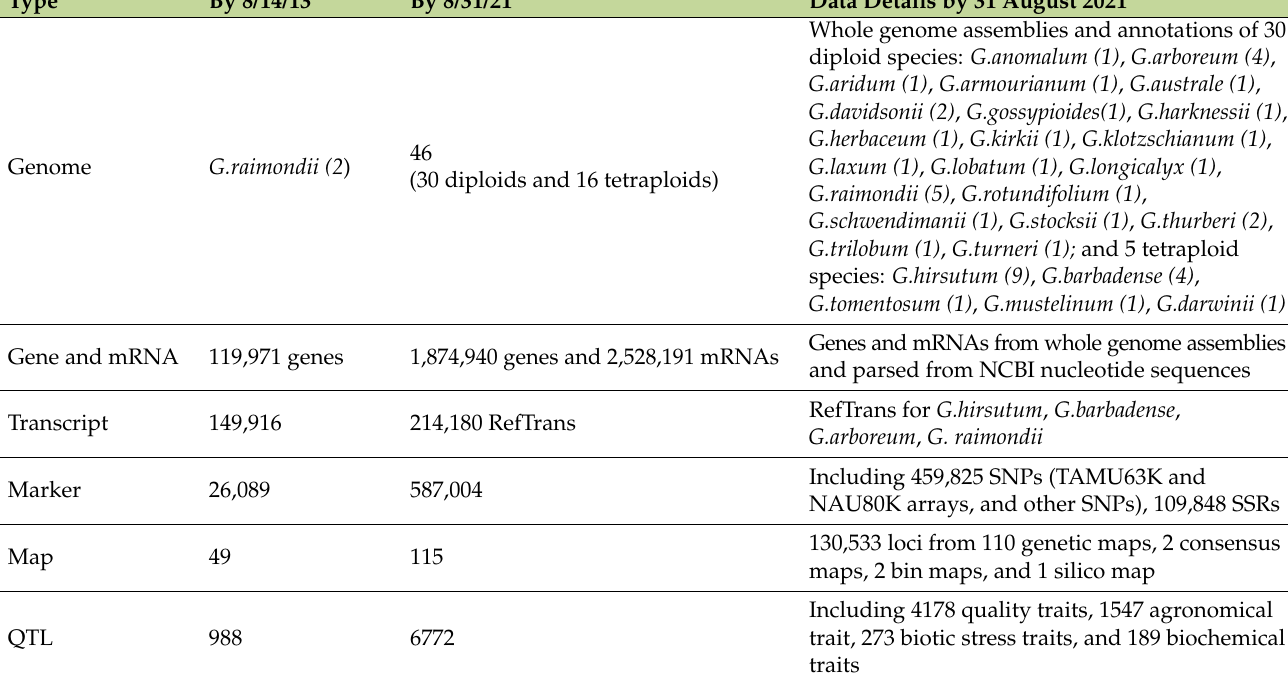
Table 1. Comparison of number of CottonGen entries between 15 August 2013 and 31 August 2021 by data type.